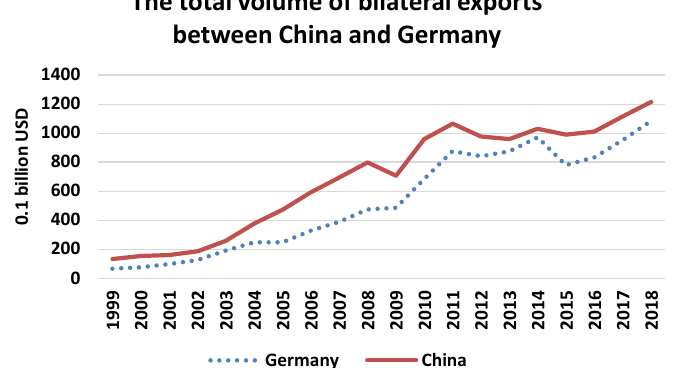
Figure 1. The trends of total bilateral exports between China and Germany from 1999 to 2018. Note: In the bottom of the graph, “Germany” stands for the export volume of Germany to China, and “China” is the export volume of China to